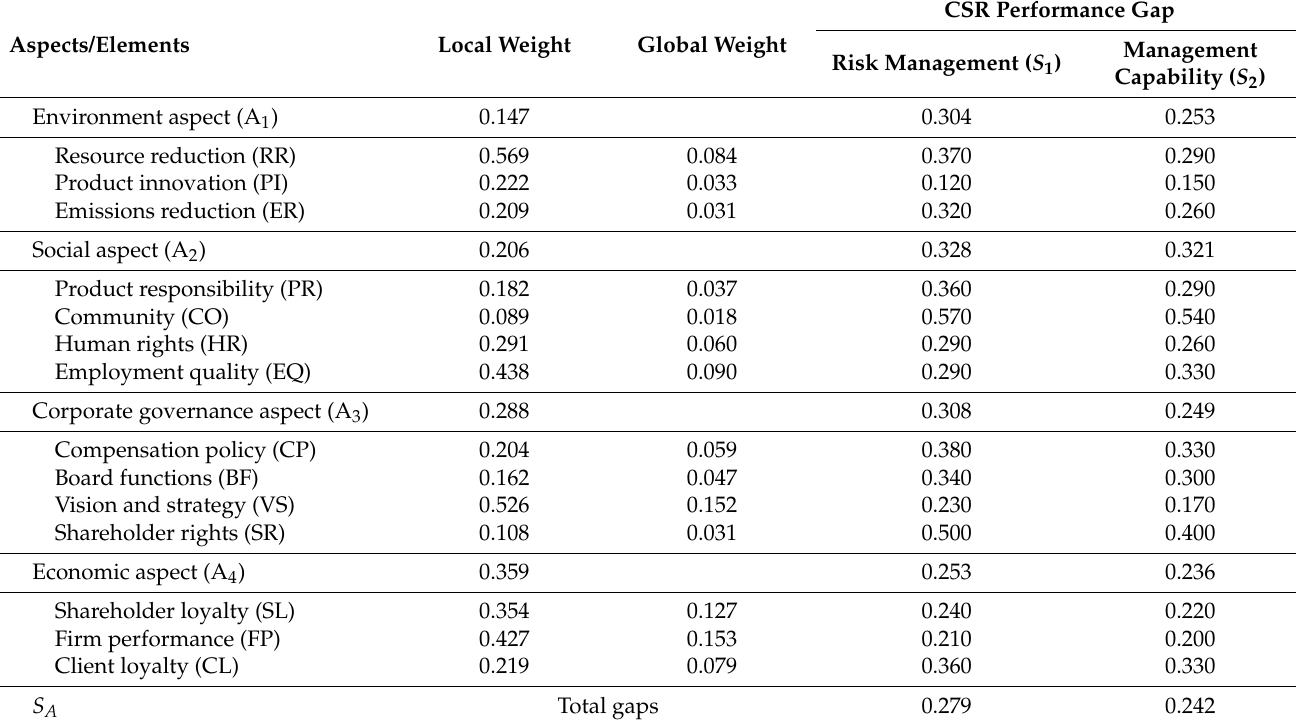
Table 3. Gap performance evaluation of CSR application in Taiwan during the COVID-19